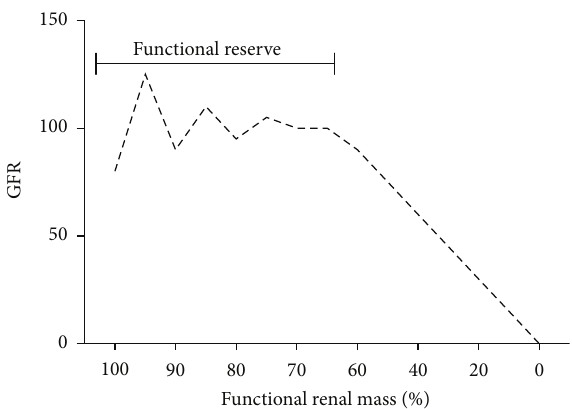
Figure 1: When enough renal mass is present, GFR changes in response to patient necessities, but when damage is severe this “renal reserve” is lost. Adapted from [12].